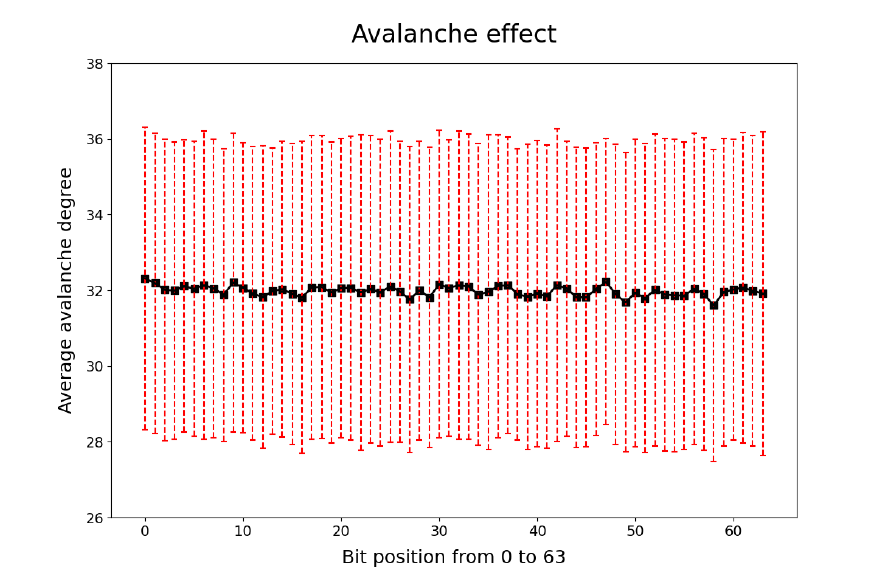
Figure 7. The average avalanche degree of